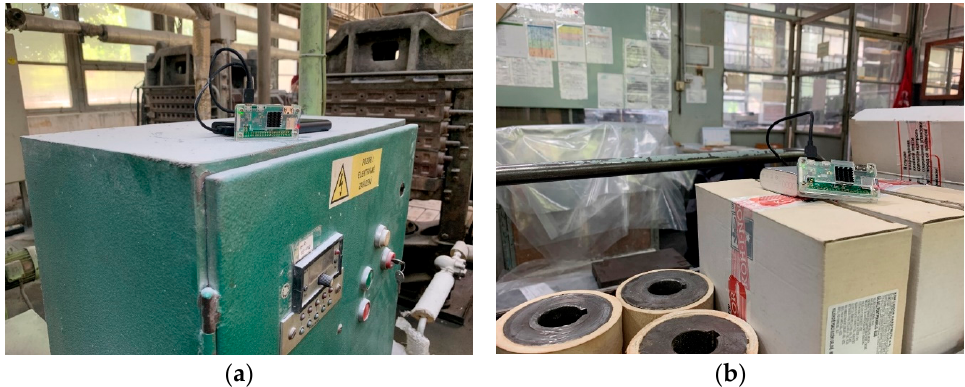
Figure 5. Placement of gateways in: ( a ) Pressing Room; ( b ) Preparation Room.